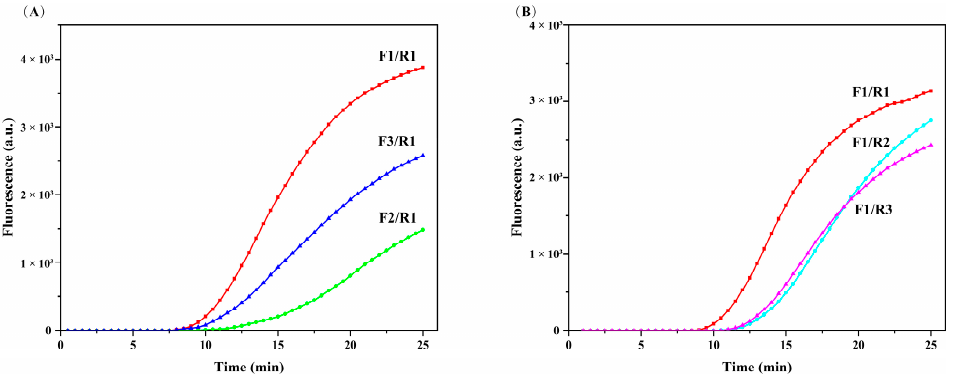
Figure 2. qRAA amplification results of the different primer combinations. Screening of upstream primer ( A ) and downstream primer ( B ). primer ( A ) and downstream primer ( B